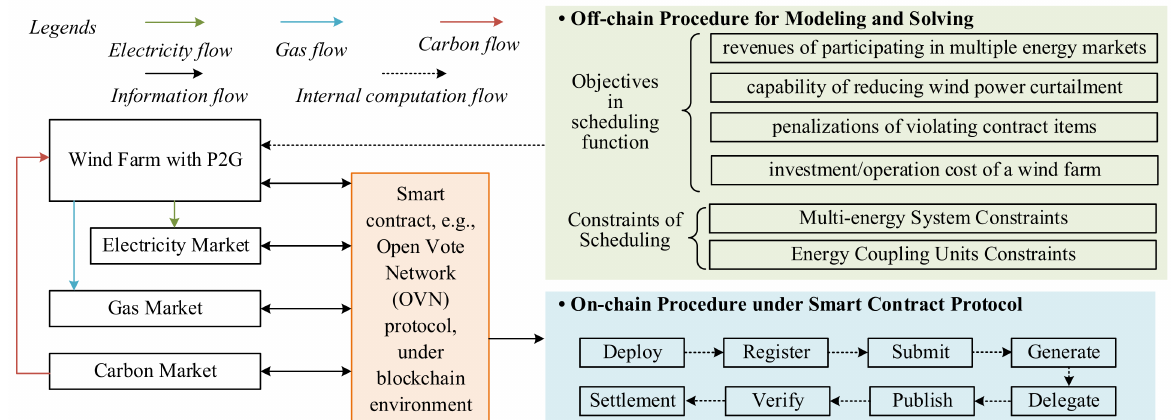
Figure 1. Framework of smart-contract-enabled automated scheduling for remote wind farms with P2G embedded considering multiple energy markets.